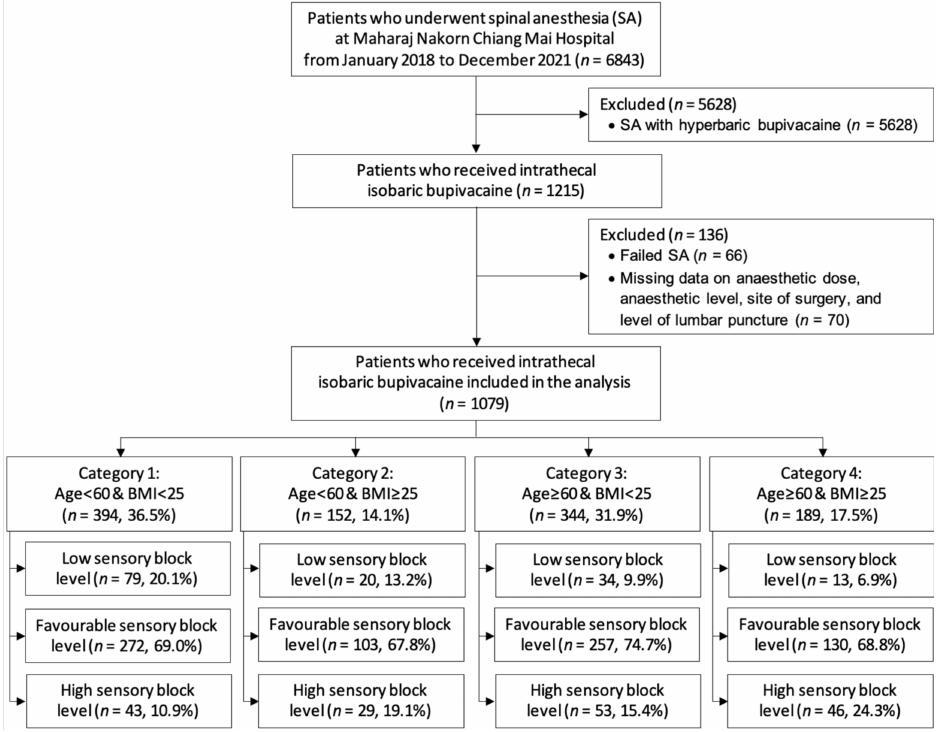
Figure 1. Study flow